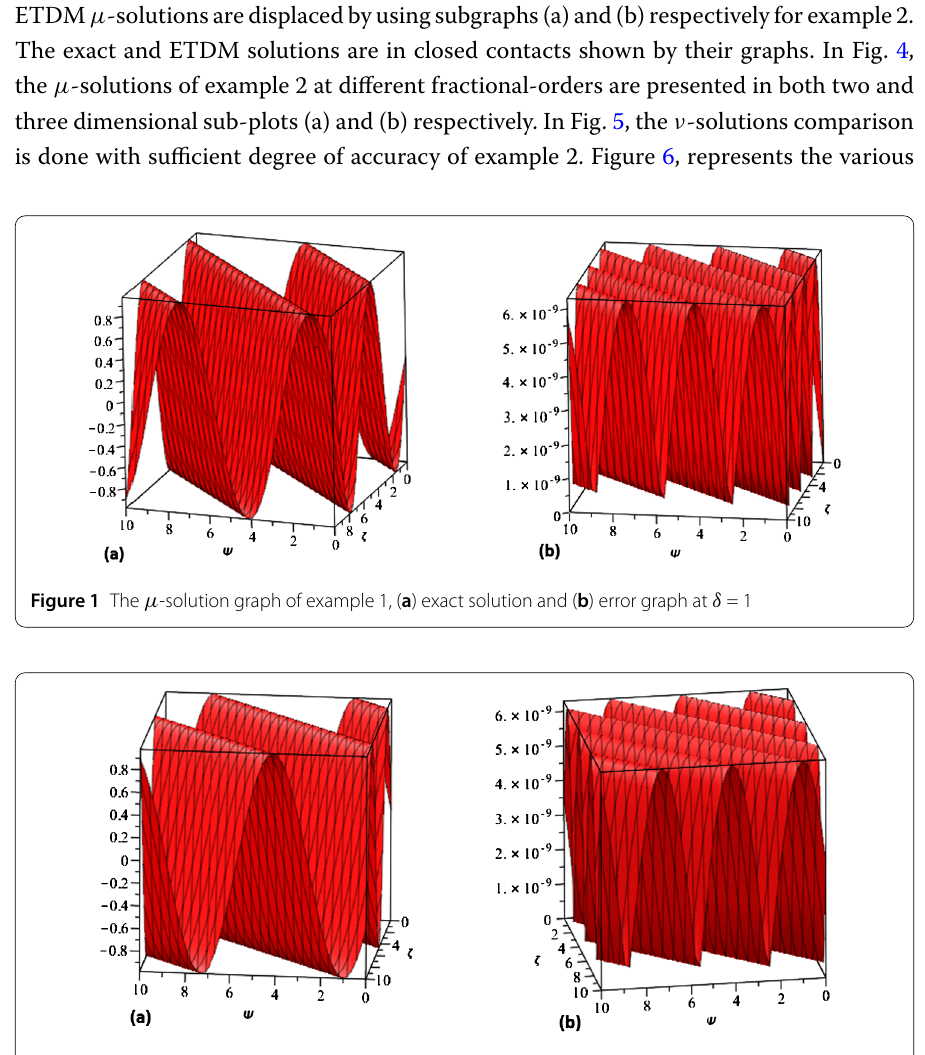
Figure 2 The ν -solution graph of example 1, ( a ) exact solution and ( b ) error graph at δ =